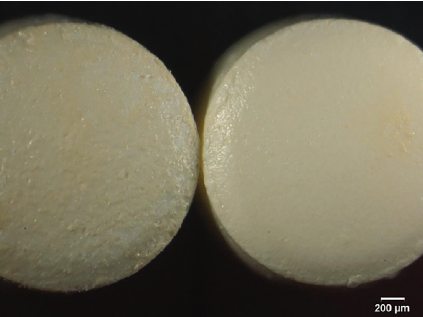
Figure 5: Stereomicrograph of well-coated tablet from experiment A3 compared to C2.